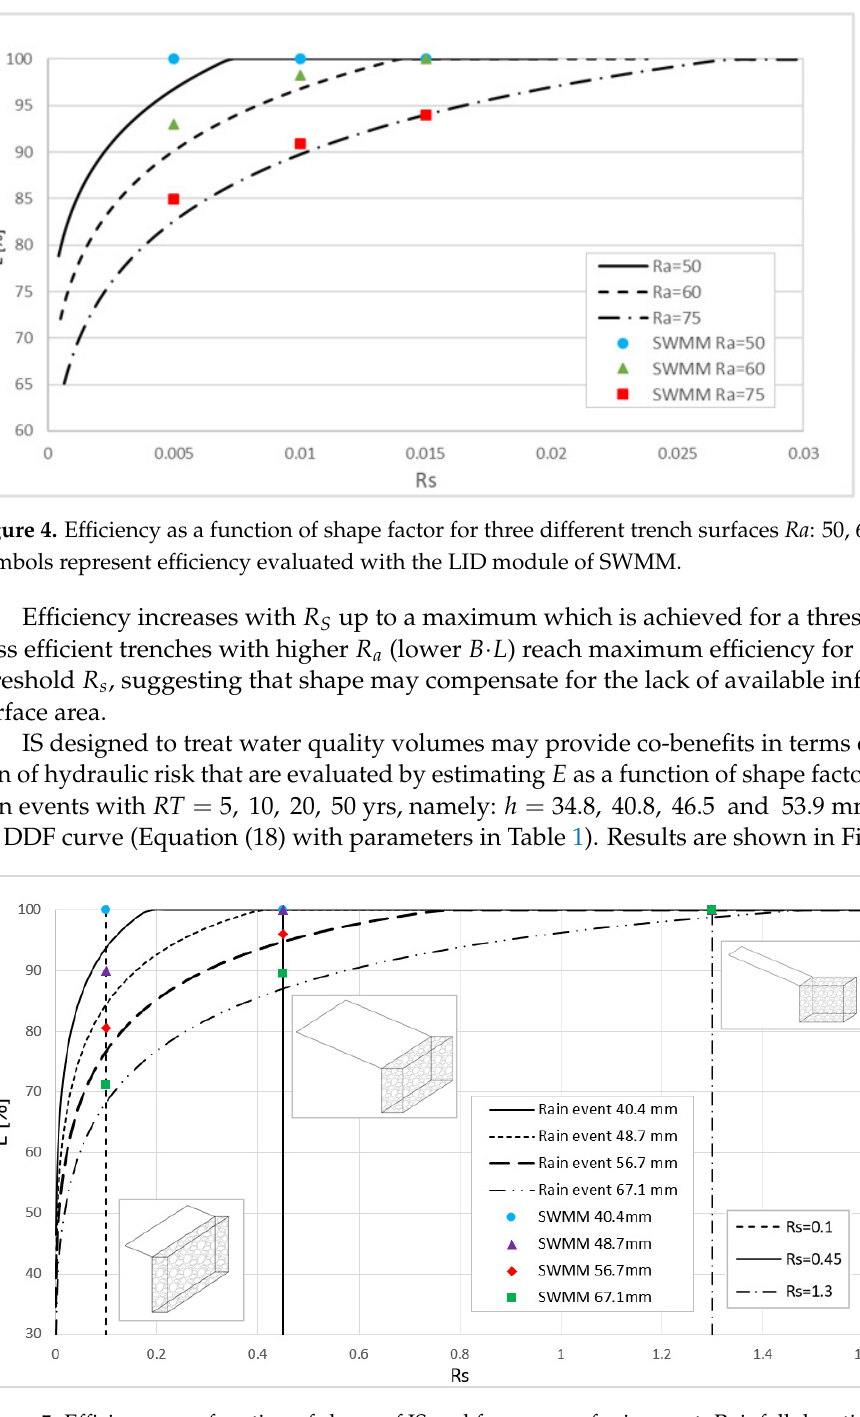
Figure 6. Efficiency as a function of trench’s depth for sandy and loamy surrounding soils after two rain events with same rain volume and different duration (low and high intensity of rainfall). 3.3. Case Study 3 The last case study involves two trenches documented in the literature by Wang and Guo [25], designed for drizzle rain with h (cid:3404) 19 mm and τ (cid:3404) 10 h ; 𝑆 (cid:3404) 20 m (cid:2870) , 𝐵 (cid:3404) 1 m , 𝐿 (cid:3404) 2 m and 𝑅 (cid:3028) (cid:3404) 15 [25]. Following the static design approach, 𝐸 (cid:3029)(cid:3048)(cid:3030)(cid:3038)(cid:3032)(cid:3047) (16) is